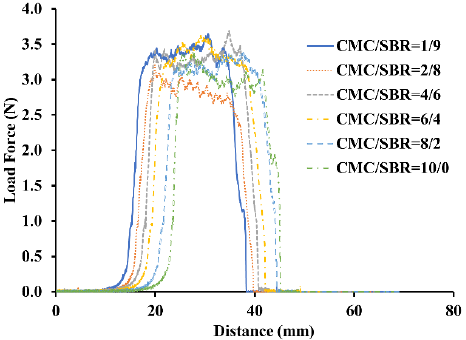
Figure 2. Peel test results of anodes made of different binder ratios of CMC and SBR.